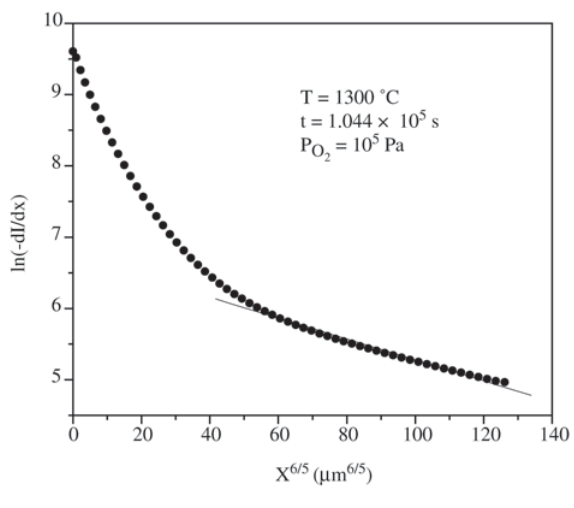
Figure 5. Comparison of volume diffusion coefficients (D) and grain-boundary diffusion coefficients (D’) obtained in the same experimental conditions.